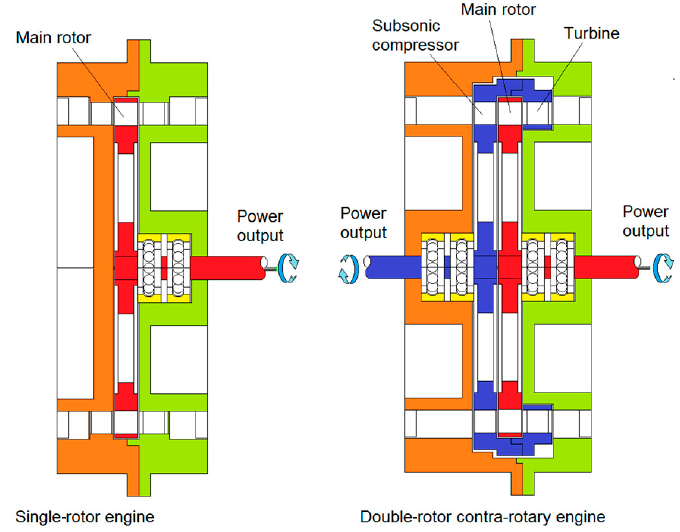
Figure 17. Comparison of the one-shaft and two-shaft engine.